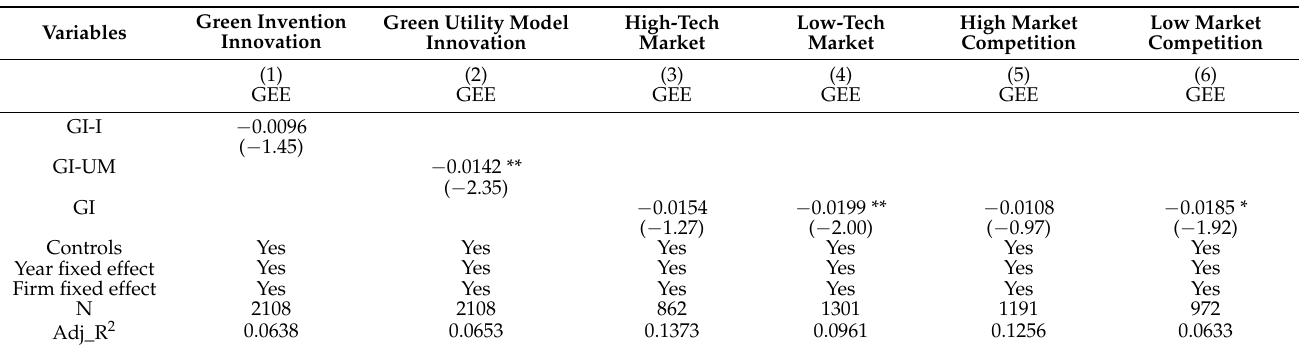
Table 5. Influence of innovation form, freedom of technological selection, and market competition